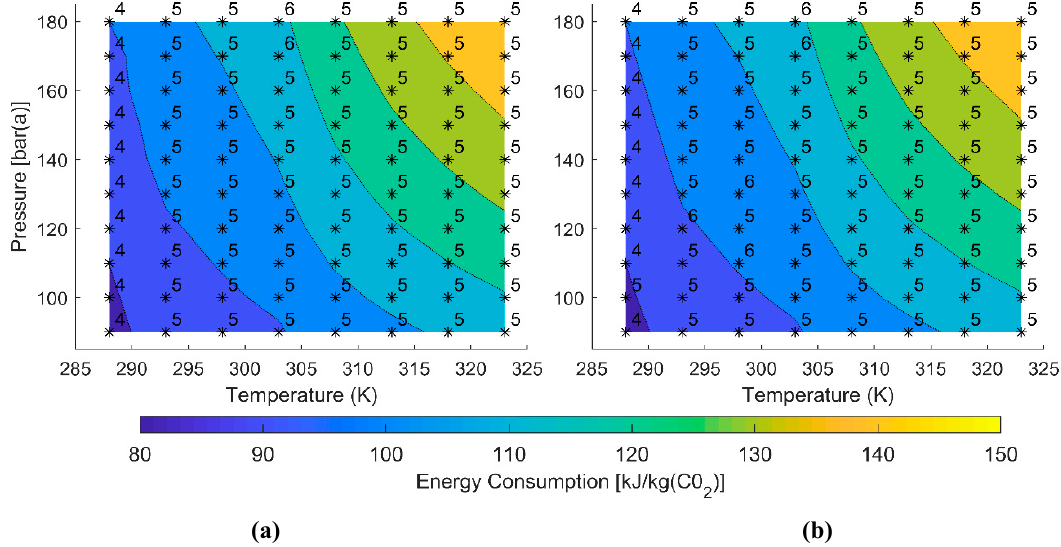
Figure 9. Oxyfuel cases, optimized compression energy consumption and number of stages, ( a ) constrained cases and ( b ) unconstrained cases.